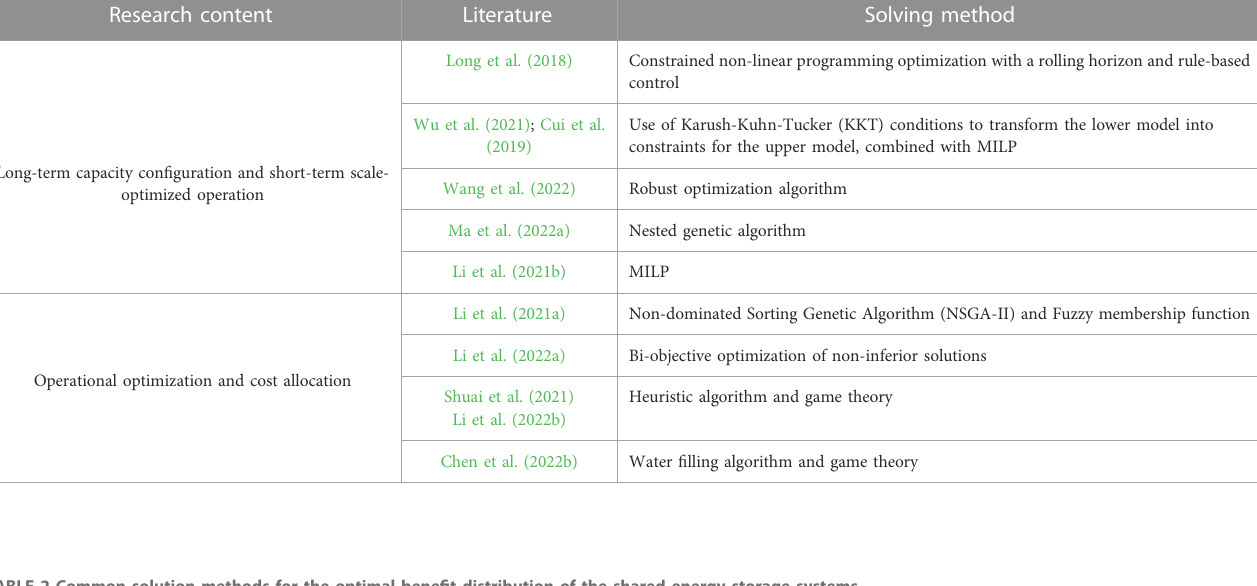
TABLE 2 Common solution methods for the optimal bene fi t distribution of the shared energy storage